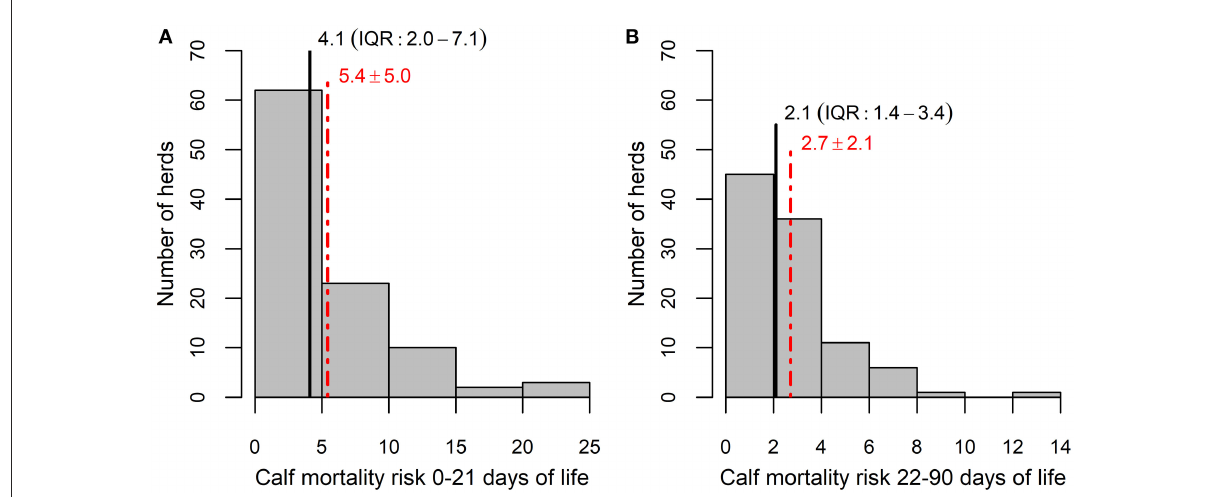
FIGURE1 Distribution of herds according to yearly calf mortality risk during the first 21 days of age (A) and 22–90 days of age (B) . The red dotted line shows the mean value and red numbers represent the mean ± standard deviation, black line shows median and black numbers represent the median and interquartile range (IQR).